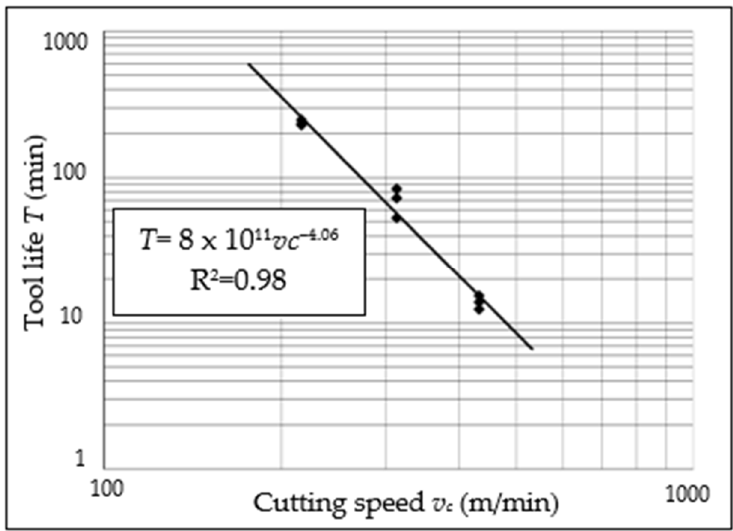
Figure 6. Graphic interpretation of Taylor’s tool life formula (relation between tool life T and cutting speed v c ).